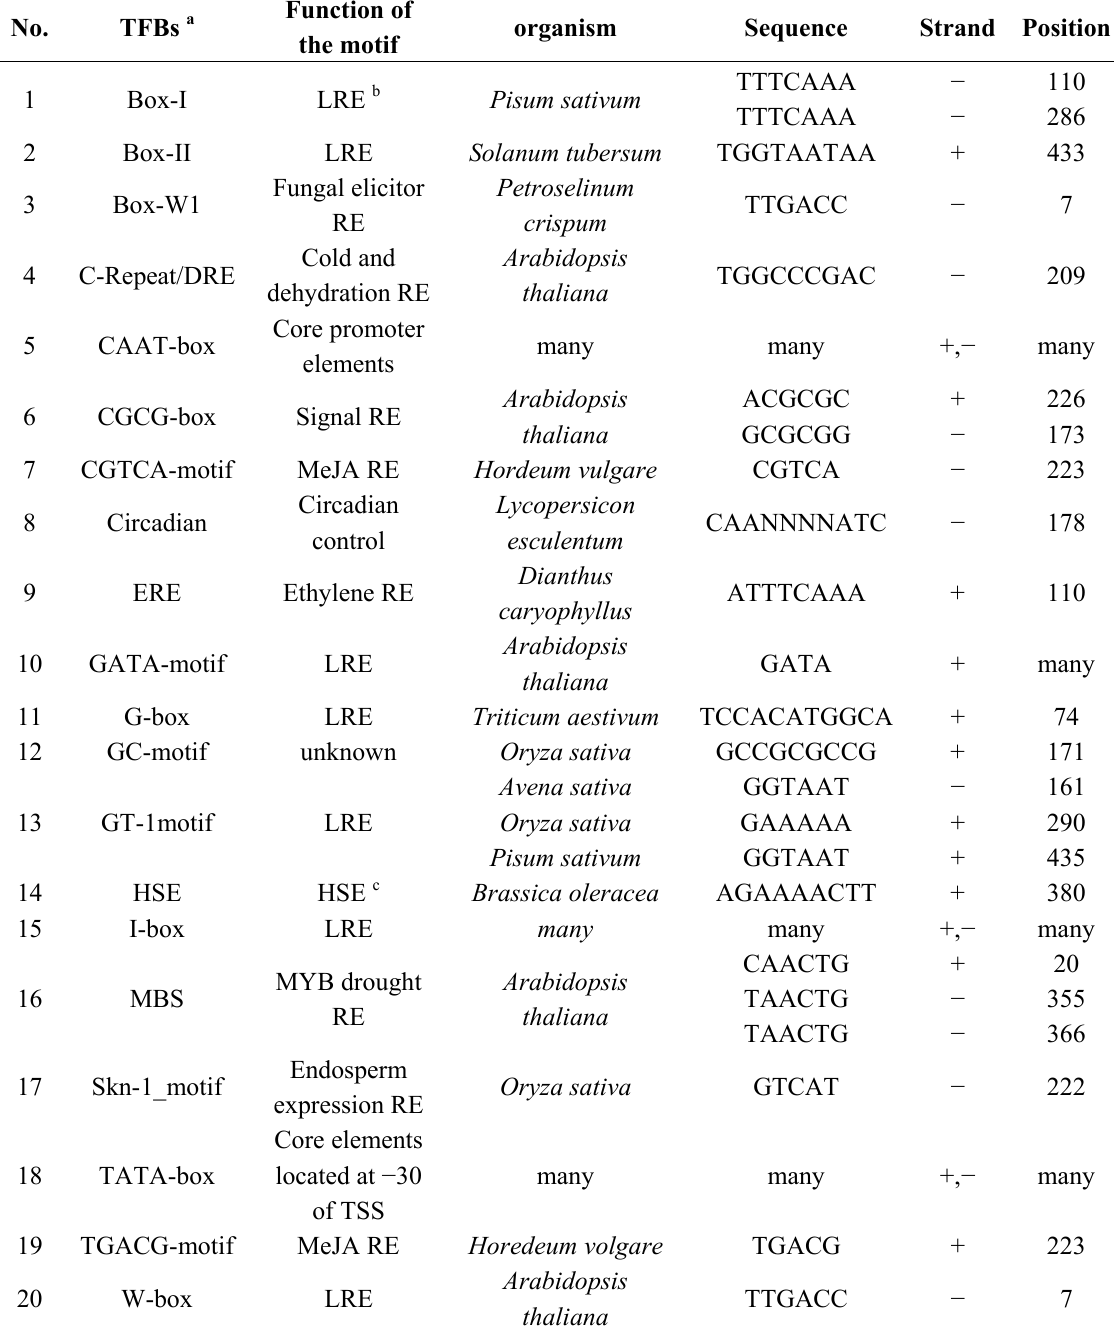
Table 1. List of putative cis -regulatory elements found in the large intergenic region (LIR) of